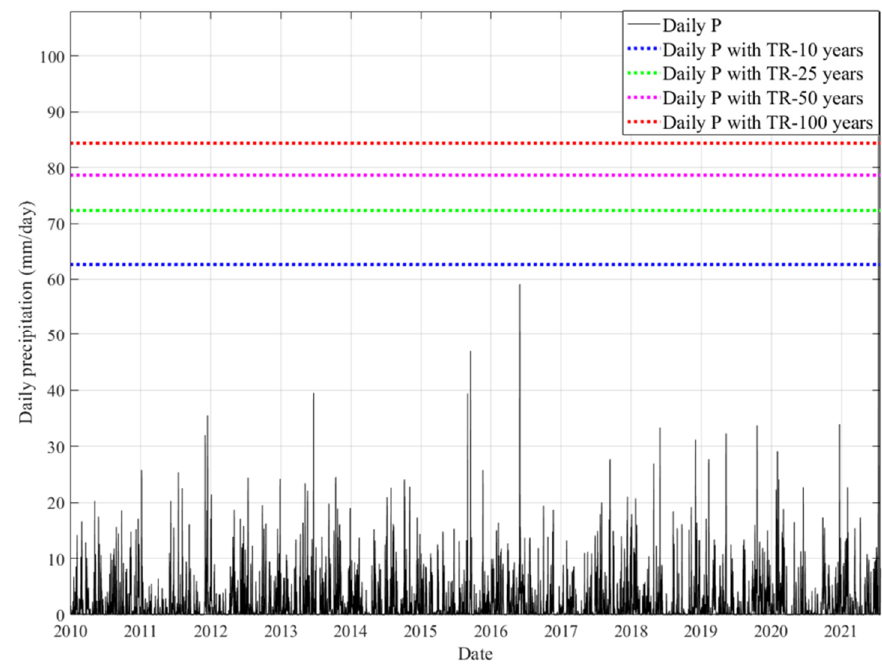
Figure 12. Return periods of maximum daily rainfall in Dudelange.